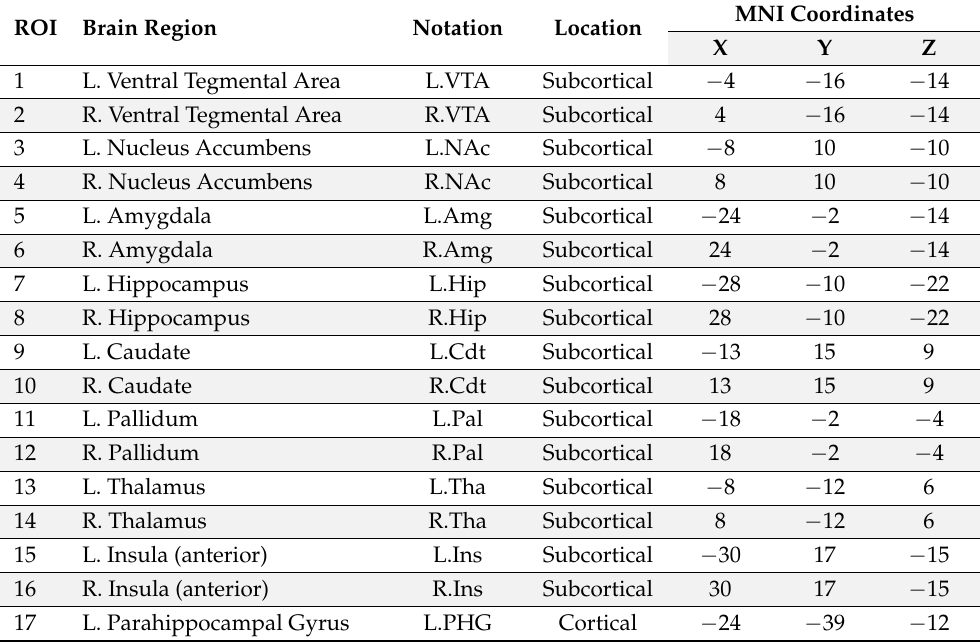
Table 2. Brain regions of interest (ROI) analyzed for reward network functional connectivity. ROI Brain